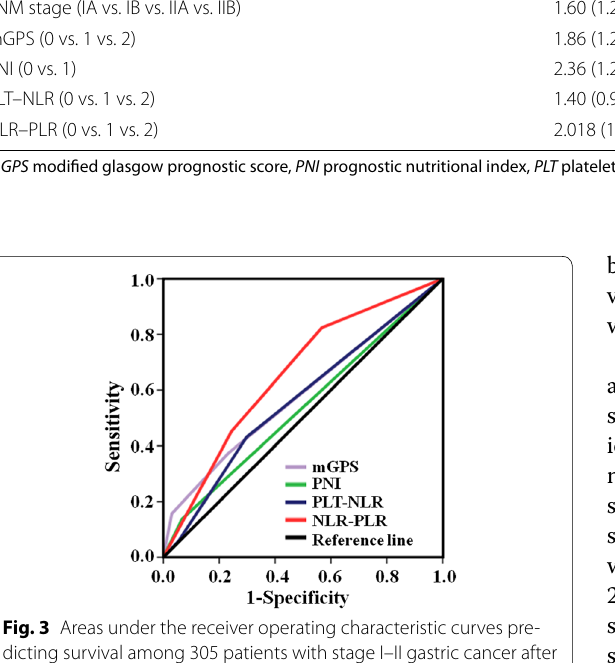
Fig. 3 Areas under the receiver operating characteristic curves pre- dicting survival among 305 patients with stage I–II gastric cancer after curative resection. mGPS modified Glasgow prognostic score, PNI prognostic nutritional index, NLR–PLR the combination of neutrophil- to-lymphocyte ratio and platelet-to-lymphocyte ratio